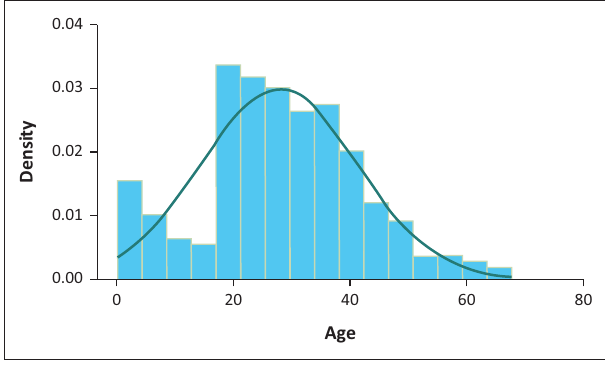
FIGURE 1: Patients’ age distribution (in